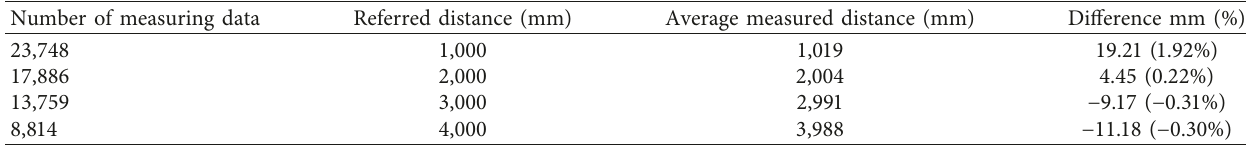
Table 4: Validation results of lidar sensor for measuring